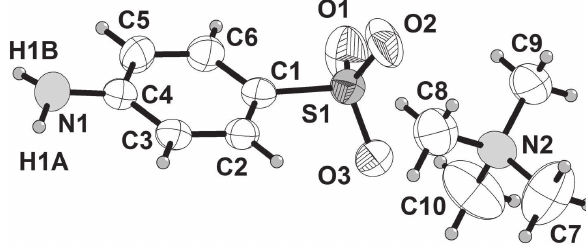
Table 1: Data collection and handling.